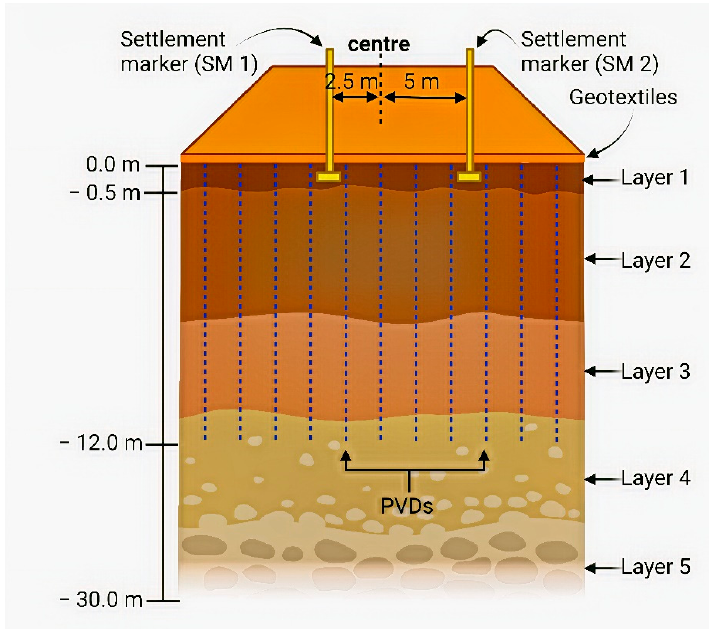
Figure 3. Ground profile and layout of field instrumentation.